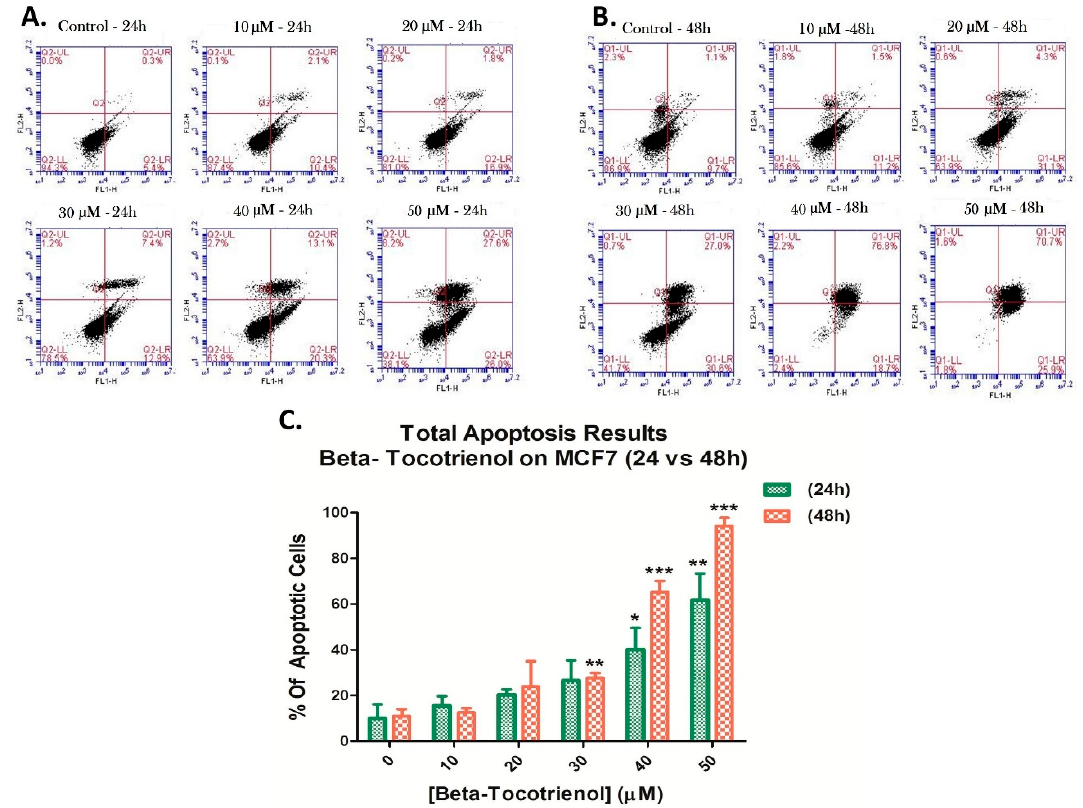
Figure 6. Beta-Tocotrienol induced apoptosis in MCF7 cells. A dual staining with Annexin V-FITC (FL1-H) and propidium iodide (FL2-H) was assessed to measure the amount of apoptosis of MCF7 cells by flow cytometry, upon 24 h ( A ) and 48 h ( B ) of treatment. Results were obtained by C-Flow software. The percentages of total apoptosis were quantified upon beta-T3 treatment and presented in histograms ( C ). *, ** and *** indicate p < 0.05, p < 0.001 and p < 0.0001 respectively. 306